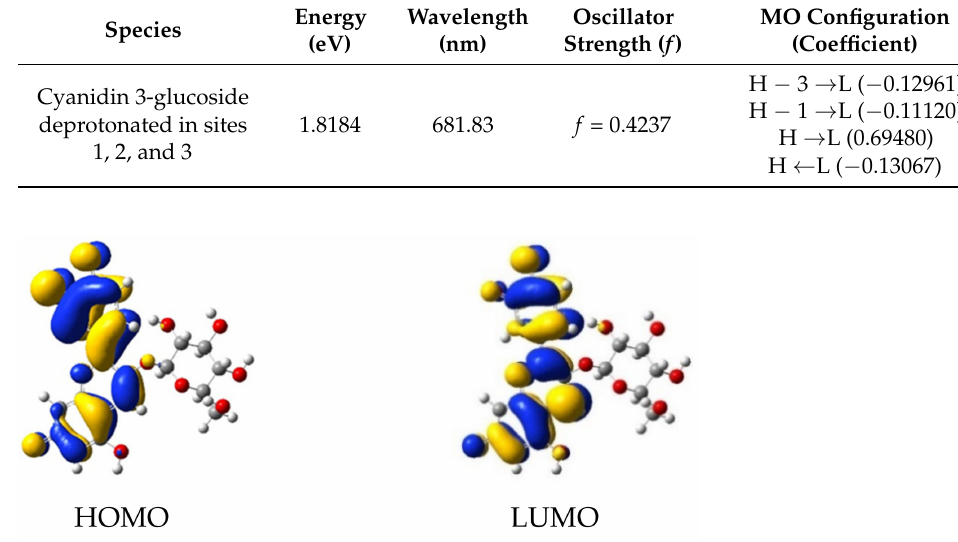
Figure 5. Molecular orbitals of cyanidin 3-glucoside deprotonated in sites 1, 2, and